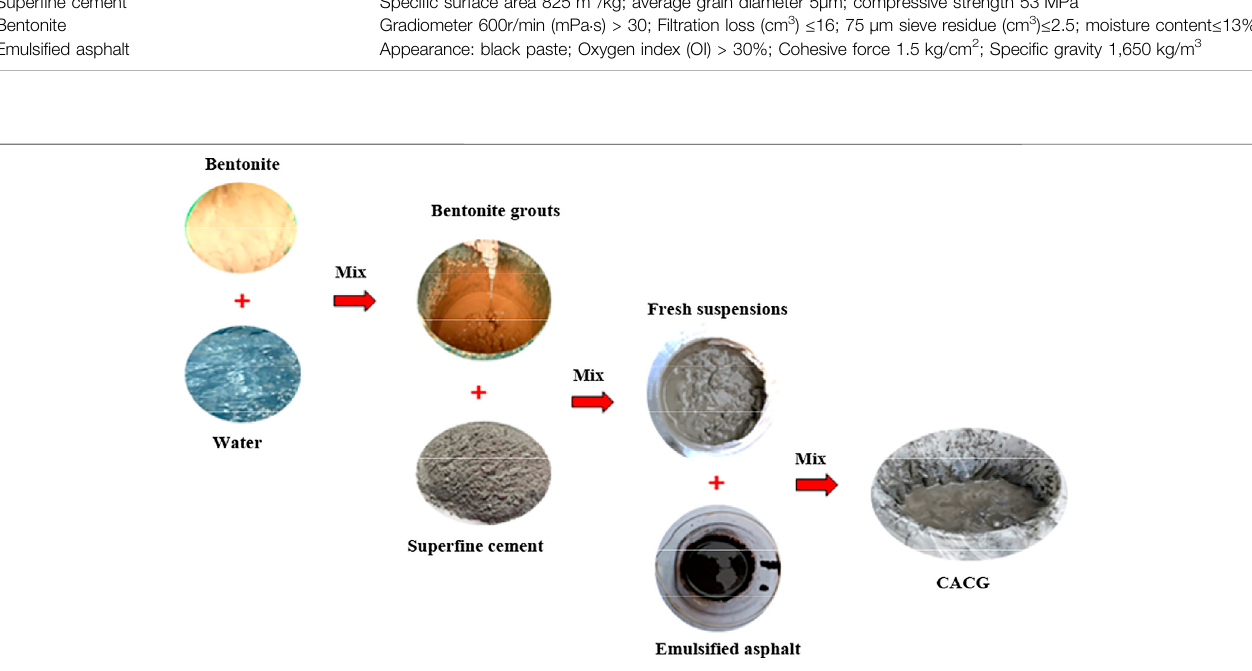
FIGURE 1 | Schematic of the CACG fabrication